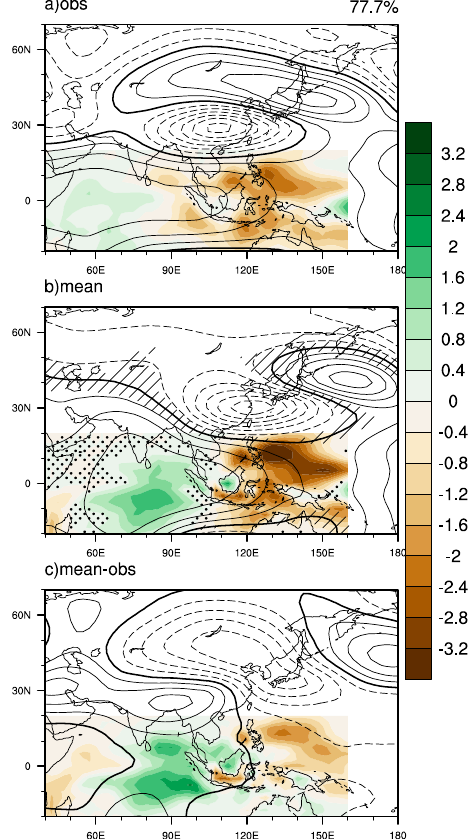
Figure 1. The first SVD mode between rainfall (shading; unit of mm/day; 20° S–20° N, 40°–160° E) and Z200 (contours; int: 5 gpm; 20° S–70° N, 40°–180° E) for ( a ) observations and ( b ) ensemble mean of SVD mode from the 30 ECHAM5 simulations, and ( c ) their differences. The number above the top-right corner of ( a ) indicates the percentage of covariance explained by the SVD. In ( b ), the stippled and slash-hatched area indicates the ensemble mean is not significant for rainfall and Z200 respectively, where the significance is defined when at least 21 out of 30 (70%) members have the same sign as the ensemble mean.